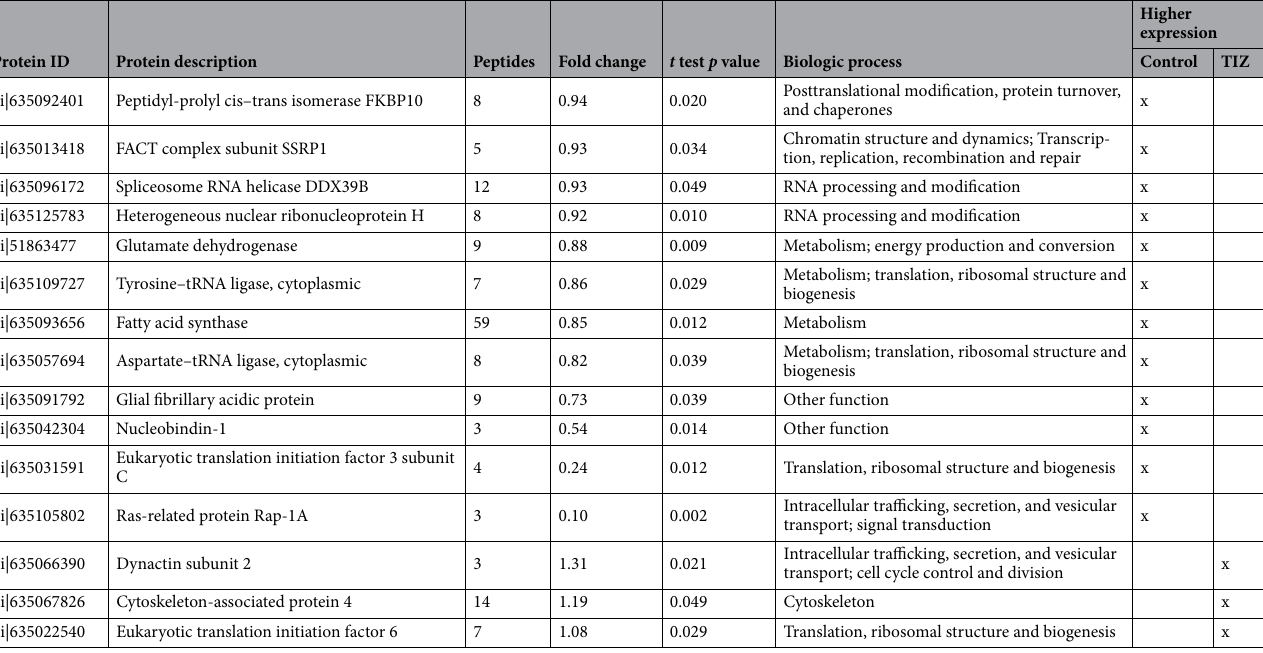
Table 1. Differential protein abundance levels in untreated and TIZ-treated Vero cells (24-h treatment) using FASP LC/MS/MS analysis. Samples in which the proteins presented statistically significant higher expression are marked